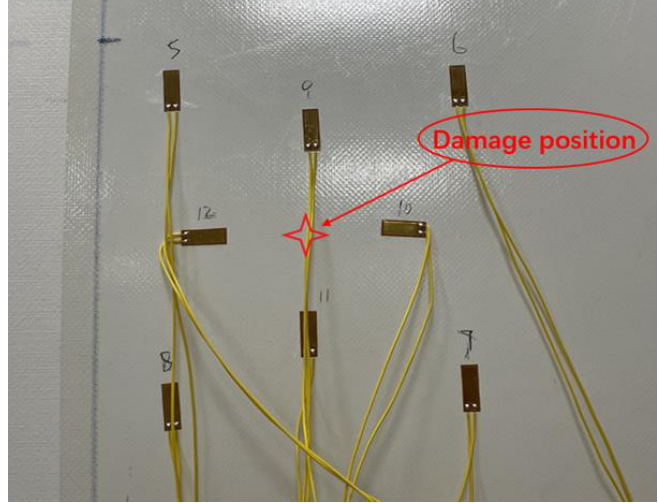
Fig. 1. Strain gauge layout and damage